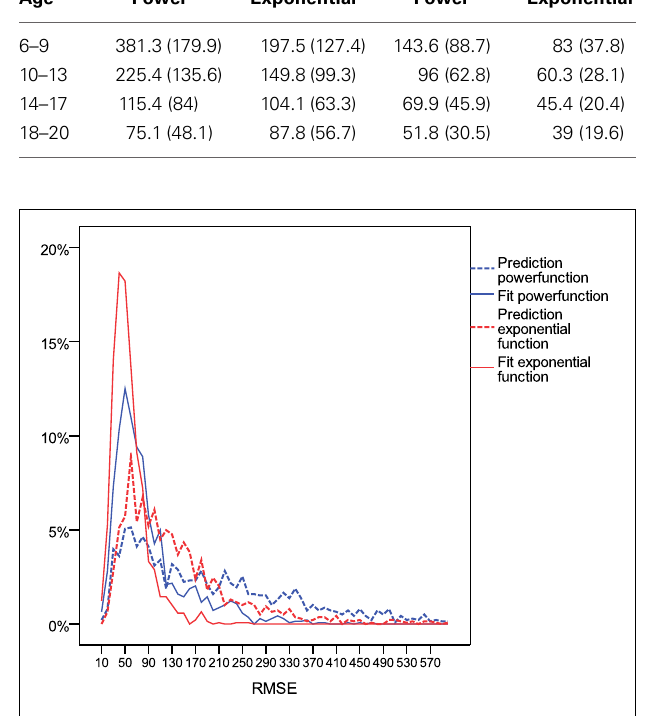
FIGURE 3 | Distribution of root mean square error (RMSE) of rating points of the power function (blue) and exponential function (red) in fitting the time course of the first 5 years (filled lines) vs. predicting the time course for the next years based on the parameters derived from fitting the first years (dotted